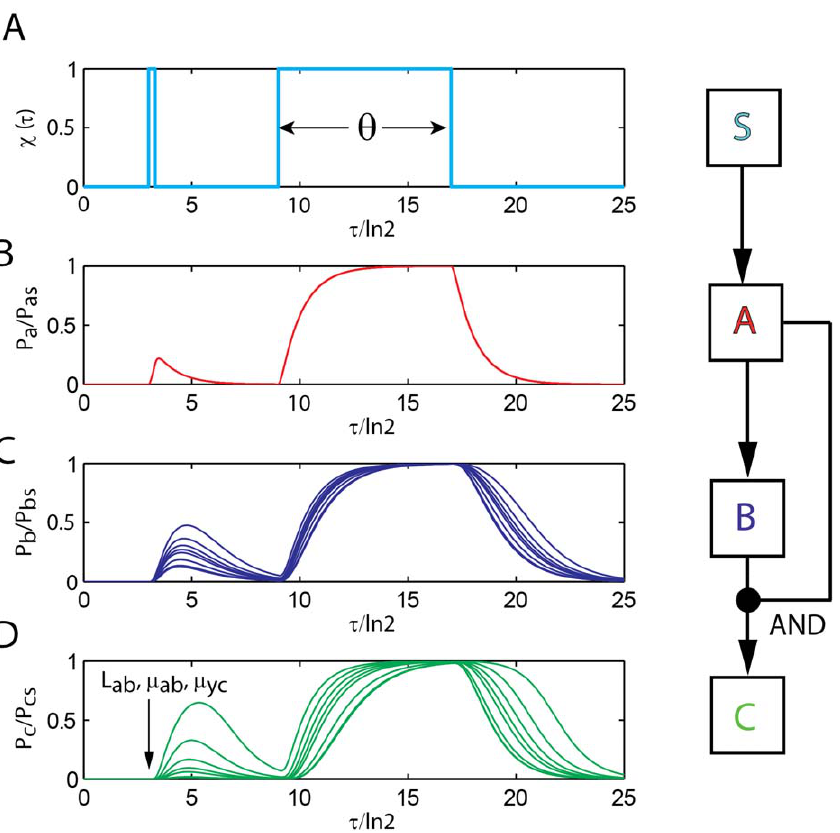
Figure 3. Dependency of filtering efficiency of P-P type (C1 type with AND-logic) FFL on the set of binding parameters (cid:2) mm . Here the general settings are: (cid:2) ww =0.12, (cid:2) vv =0.0003, (cid:2) ss =4, T =25 generation times, and (cid:2) mm was varied as (0.1, 0.2, 0.3, 0.4, 0.5, 1, 3 and 5). A. Input signal at the promoter of TF gene A. This has one short rectangular pulse with a width of h = 0.3 and a large one with h = 8 all are measured in terms of number of generation times. B. TF gene A responds similarly for all values of (cid:2) mm to both the signals irrespective of the binding strengths. The response seems to be proportional to the pulse width h without any delay. C. As binding strength increase, the response of B also increases proportionately. D. There exists a cutoff value of (cid:2) mm above which the expression level of TF gene C is practically zero. With the current settings, this cutoff seems to occur at (cid:2) mm =1. Arrow shows the increasing direction of (cid:2) mm .